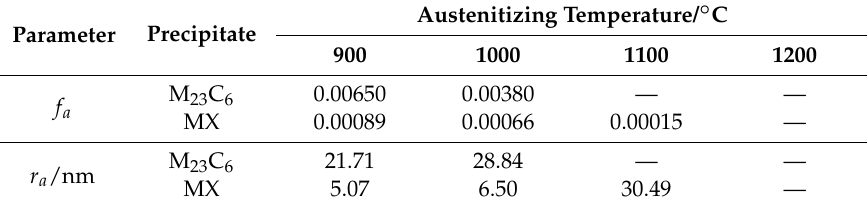
Table 2. Average volume fraction f a and radius r a of precipitates at different austentitizing temperatures. Austenitizing Temperature/°C Parameter Precipitate